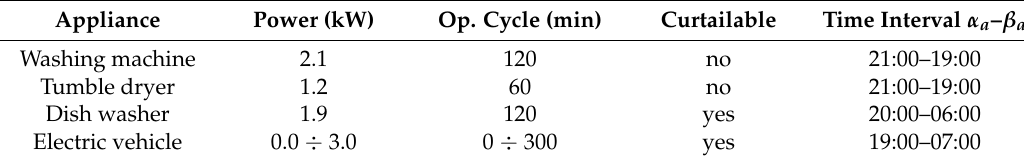
Table 1. Shiftable appliances parameters.